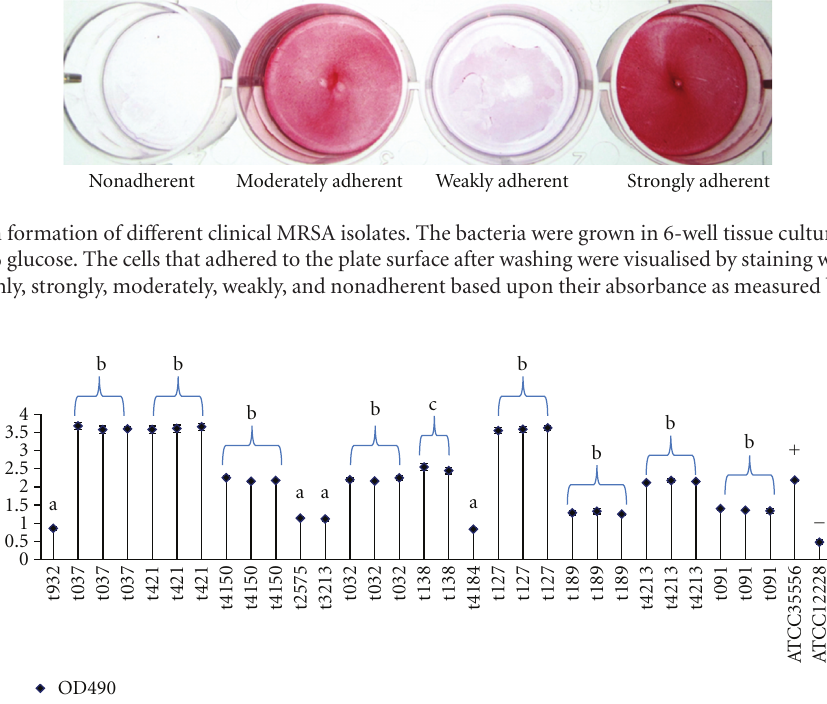
Figure 2: A chart displaying each spa type measures the quantity of biofilm using a microtiter plate assay for all isolates of this spa type represented as dots. Data represent the mean of triplicate determinations of the increase in bacterial adhesion. An OD value of 0.5 was selected as the cut-o ff point; any OD value above the cuto ff OD was considered positive for biofilm formation. The isolates of one clone have similar quantitative biofilm-forming properties. The isolates of di ff erent clones have di ff erent quantitative biofilm forming properties. (a) Indicates to the single frequently isolates belonging to di ff erent spa typing. (b) Indicates to the three similar isolates of one clone. (c) Indicates to the two similar isolates of one clone. +: Indicates to the positive biofilm reference strain. − : Indicates to the negative biofilm reference strain.